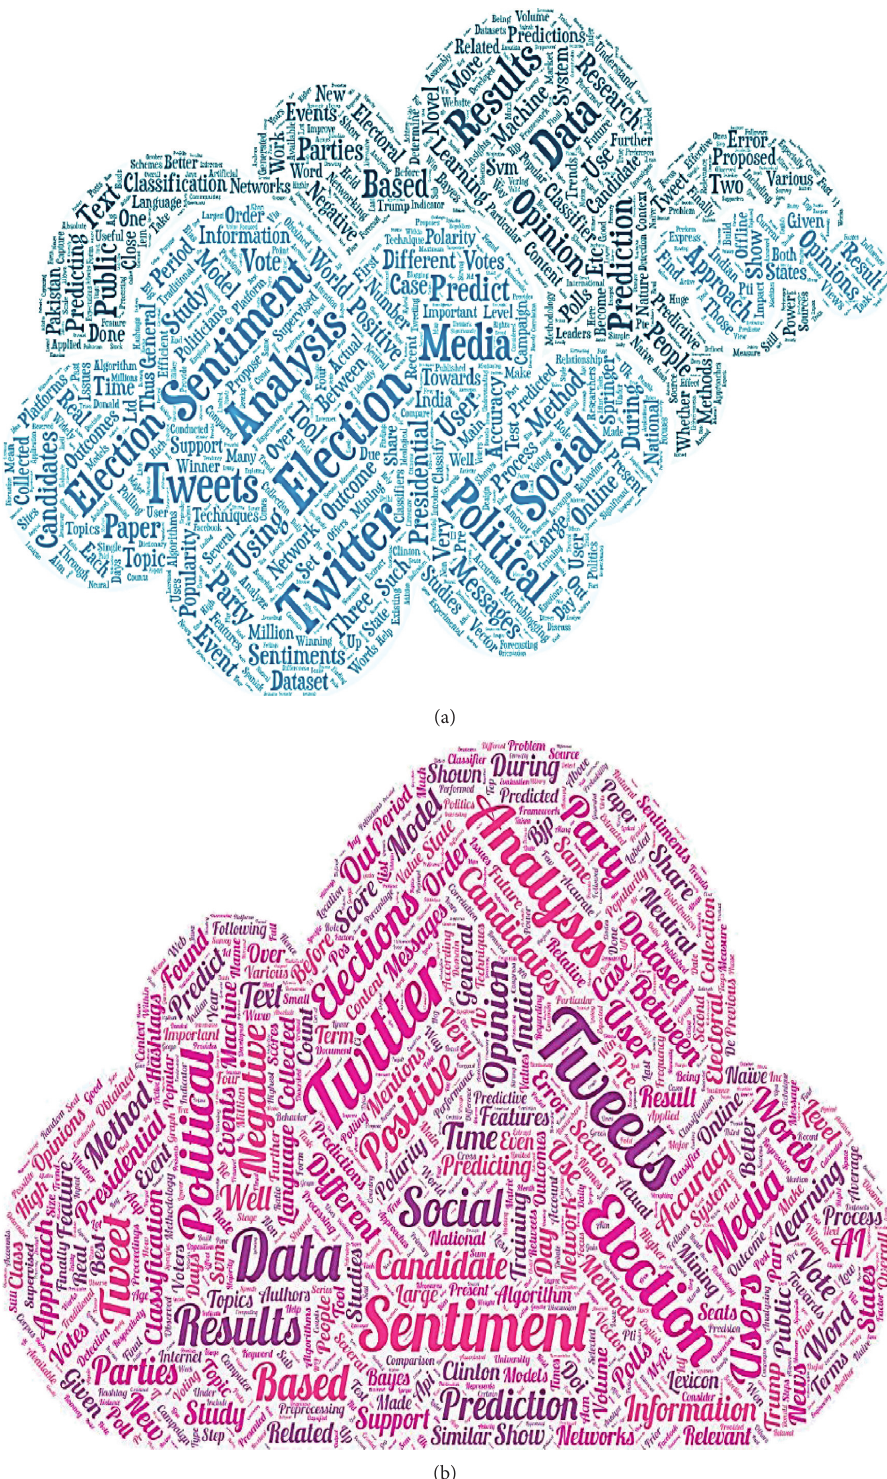
Figure 16: (a) Word cloud of the selected studies’ abstracts and (b) word cloud of the selected studies’